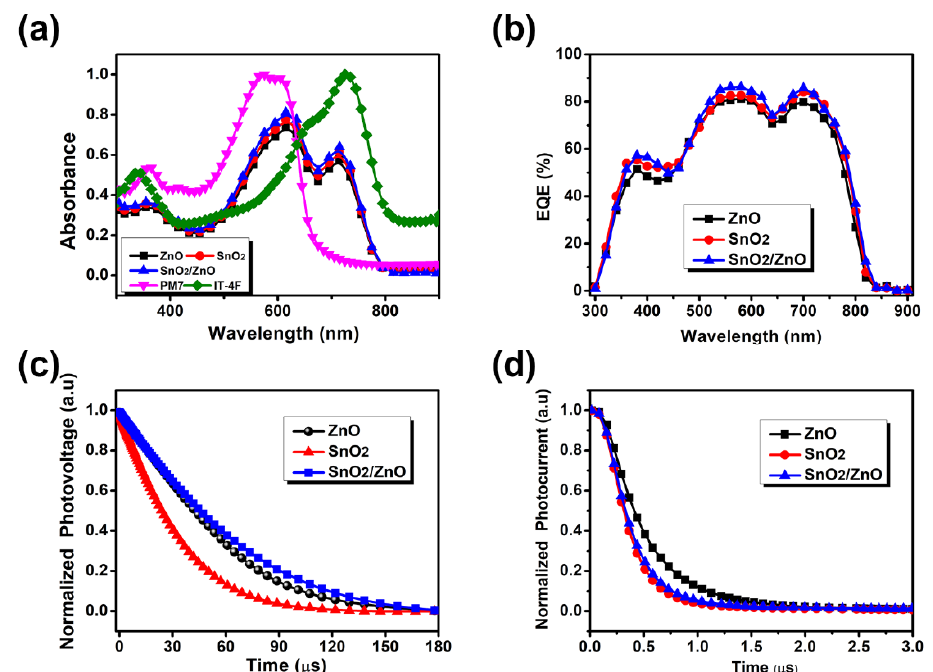
Figure 2. ( a ) UV-Vis absorption spectra and ( b ) the EQE spectra of the devices; Normalized ( c ) TPV and ( d ) TPC decay curves of the device with different cathode buffer and ( d ) TPC decay curves of the device with different cathode buffer layers.